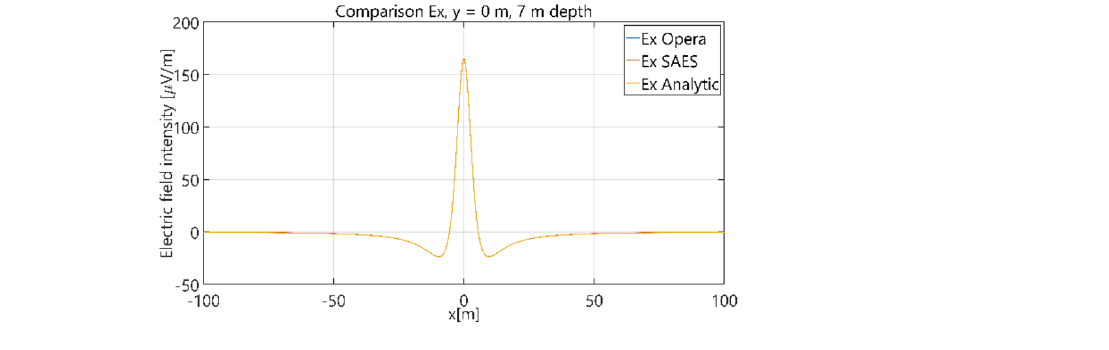
Figure 20. Distribution of E x component ( y = 0 m, z = − 7 m, case